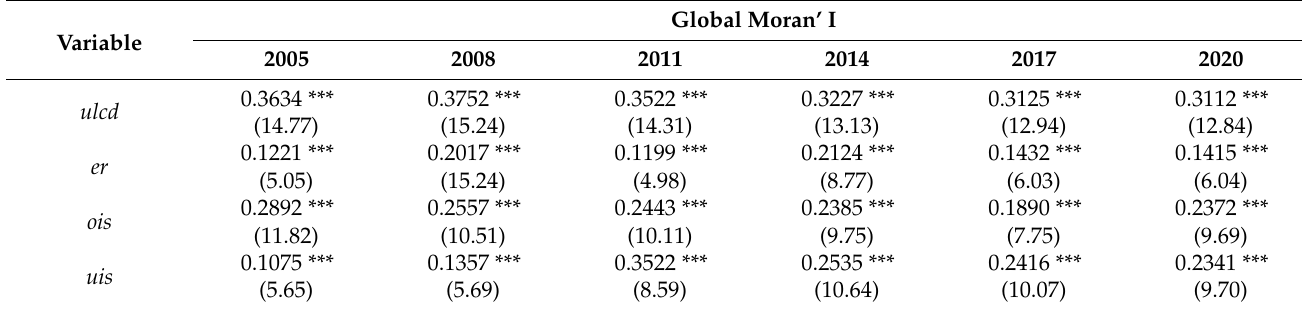
Table 3. Global Moran’ I of main variables from 2005 to 2020.